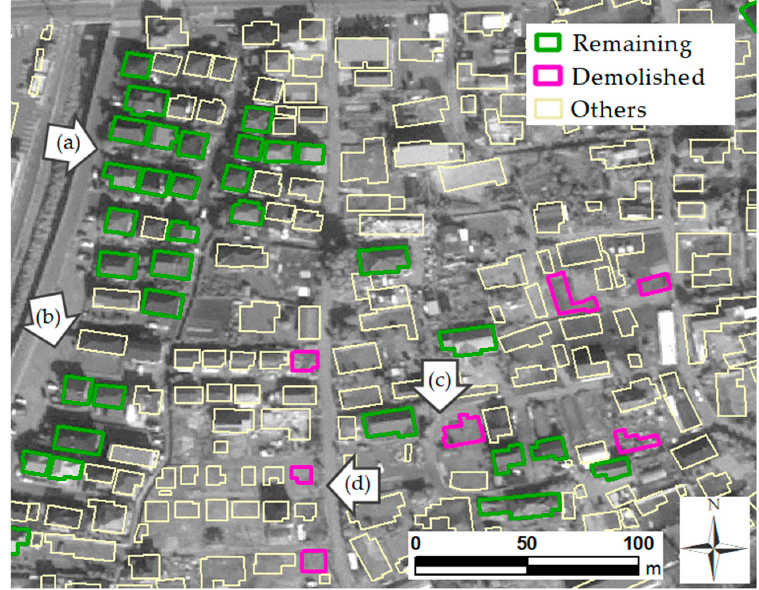
Figure 8. Dataset polygon to establish a model by field survey of the area with a background image of Pleiades observed on 1 January 2017. Arrow positions ( a – d ) of sample photos in Figure 7.